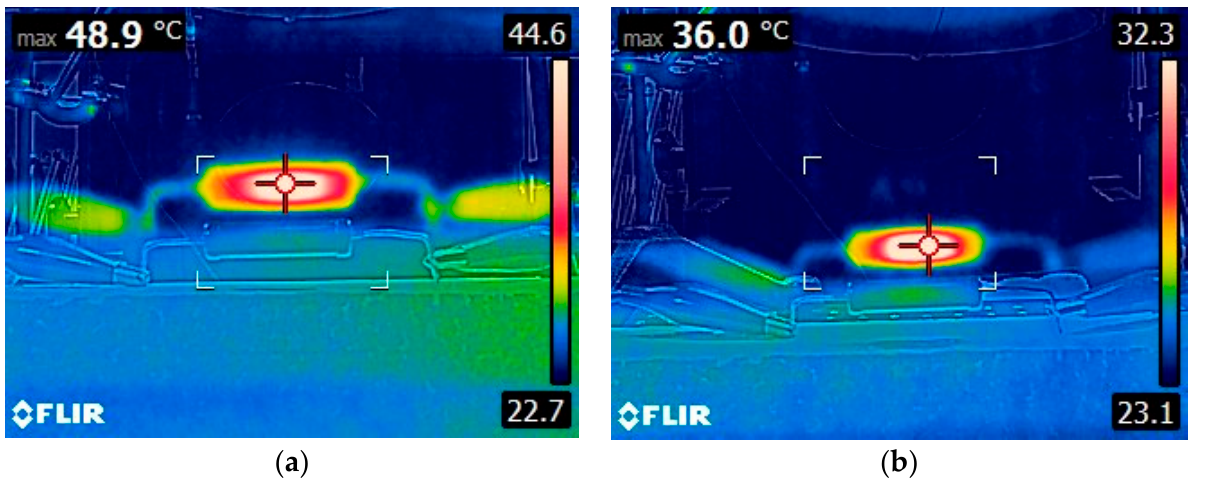
Figure 12. Thermal image of the power resistor at a stabilized temperature ( a ) with no cooling, ( b ) cooled with EHD air fl ow at U = 20 kV.